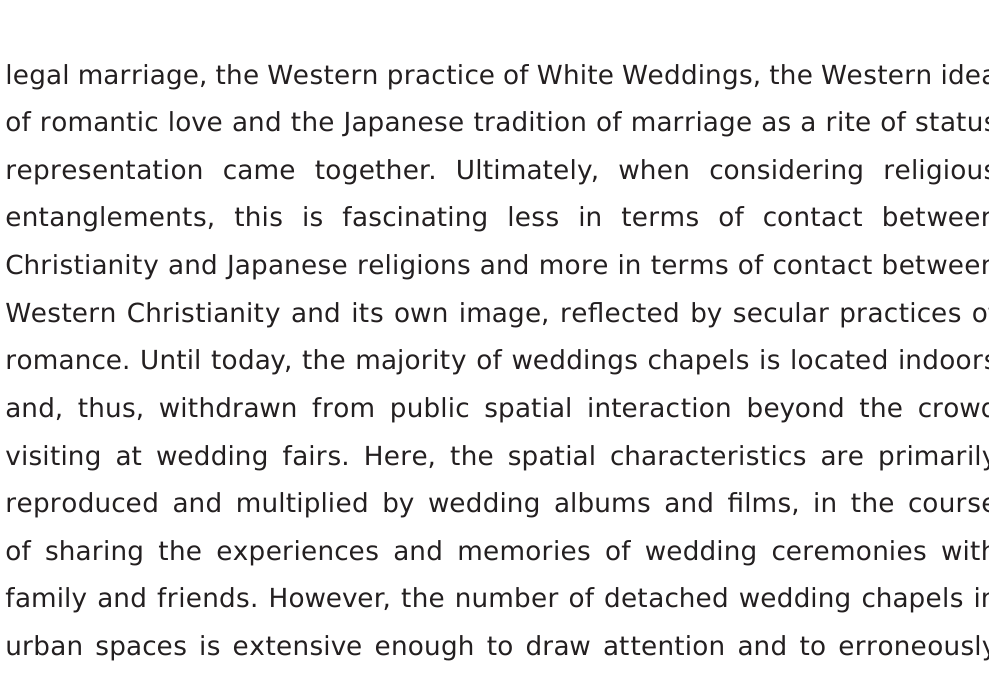
ST. GRACE CATHEDRAL TOKYO-SHIBUYA